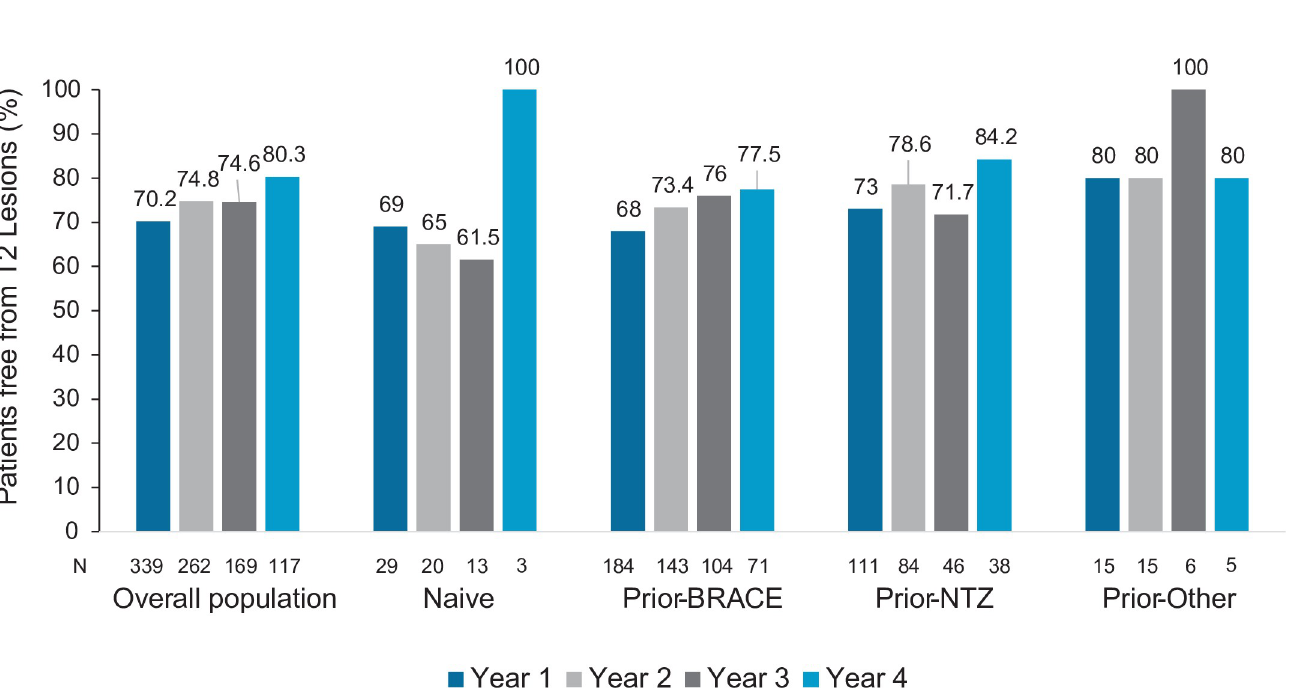
Fig 4. Patients free from new/enlarged T2 lesions in the overall population and prior treatment subgroups. Abbreviatures : BRACE: Betaseron (interferon beta- 1b sc), Rebif (interferon beta-1a sc), Avonex (interferon beta-1a im), Copaxone (Glatiramer acetate), and Extavia (interferon beta-1b sc); EDSS, Expanded Disability Status Scale; IQR, interquartile range; N: Number of patients with available data for T2 Lesions; NTZ, natalizumab.